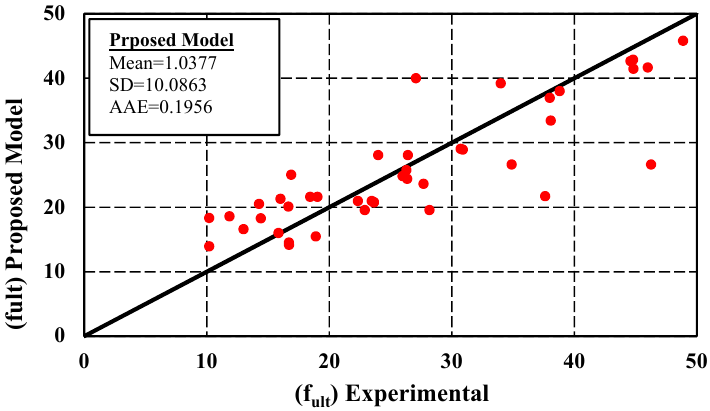
Figure 14. Comparison of 𝐟 𝐮𝐥𝐭 values obtained from the proposed model and experimental data.